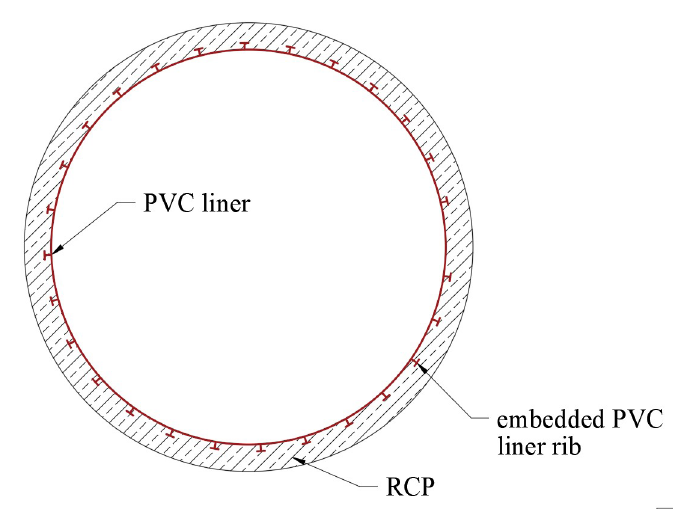
Figure 7: Reinforced concrete pipe with PVC